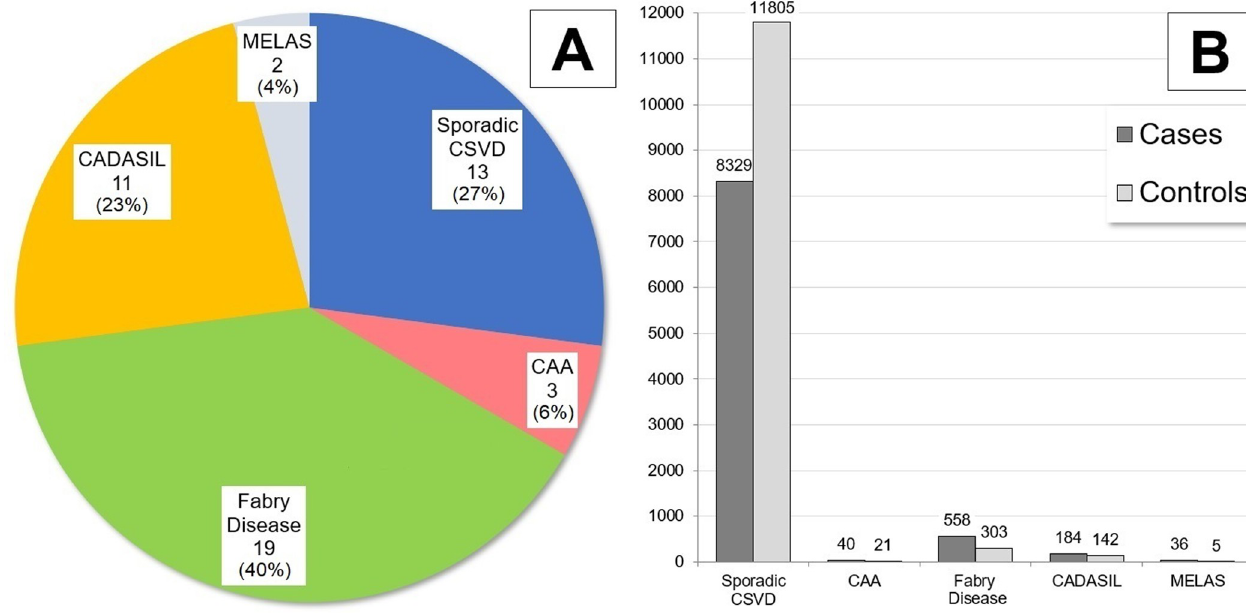
Fig 2. Number and sample size of studies included in systematic review. Panel A: Number and percentages of studies included in the present systematic review, based on CSVD disorder of interest. Panel B: Number of affected (cases) and healthy (controls) individuals participating in studies included in the present systematic review, based on CSVD disorder of interest. Abbreviations: CAA = Cerebral Amyloid Angiopathy, CADASIL = Cerebral Autosomal Dominant Arteriopathy with Subcortical Infarcts and Leukoencephalopathy, CSVD = Cerebral Small Vessel Disease, MELAS = Mitochondrial Encephalomyopathy, Lactic Acidosis, and Stroke-like episodes